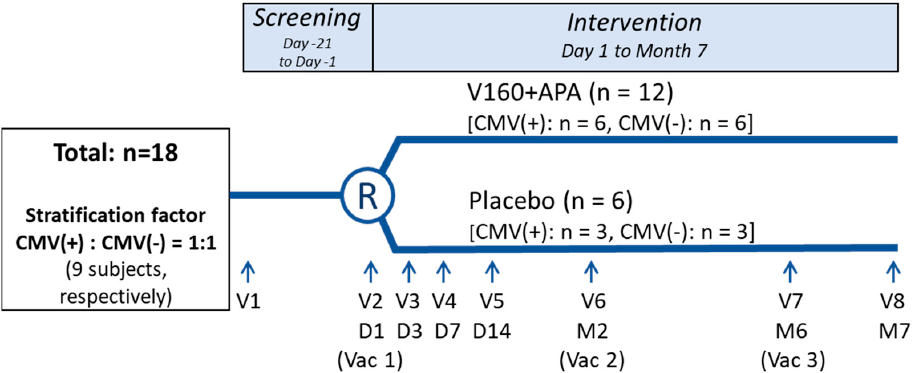
Figure 1. Study design. Abbreviations: APA, aluminum phosphate adjuvant; CMV, cytomegalovi- rus; D, day; M, month; R, randomization; V, visit; Vac, vaccination. D, day; M, month; R, randomization; V, visit; Vac,